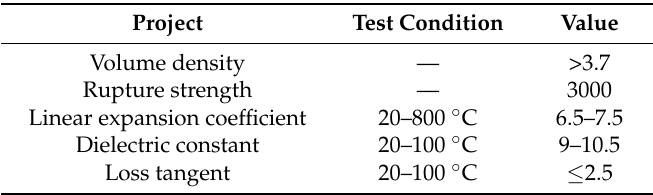
Table 2. Performance index of alumina ceramics.